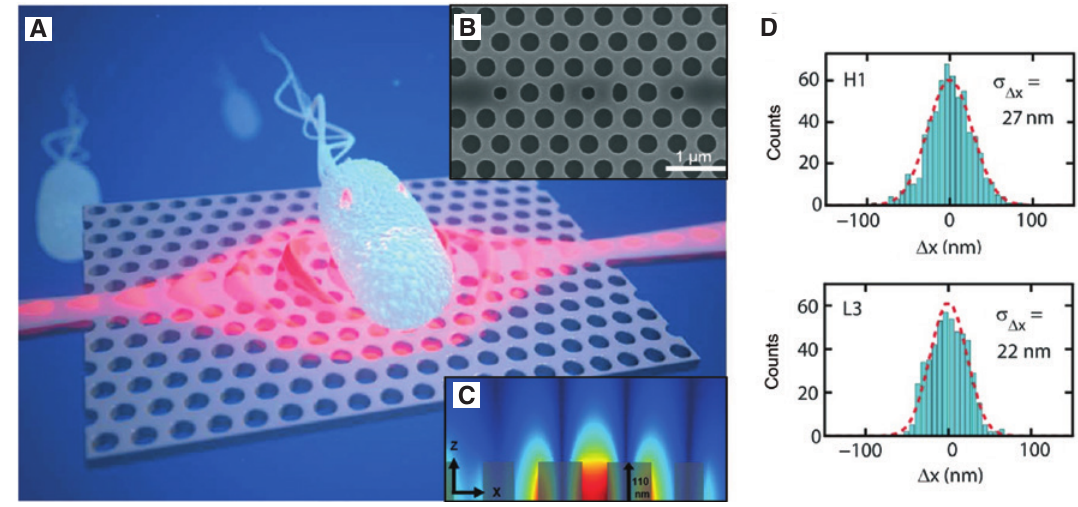
Figure 24: Photonic crystal microcavities as localised optical traps for bacteria. (A) Artistic rendition of optical trapping of single bacteria using PhC cavities for local enhancement of the evanescent field. (B) SEM image of a H1 cavity in a PhC. The central hole is smaller than the regular holes and the adjacent ones are duly optimised. (C) Mode profile of the (cid:31) cavity. The amplitude of the electric field | | E is in the vertical plane through the central x -axis. (D) Histograms of the displacement of the trapped B. subtilis spore from the central position for different PhC cavities. Adapted from